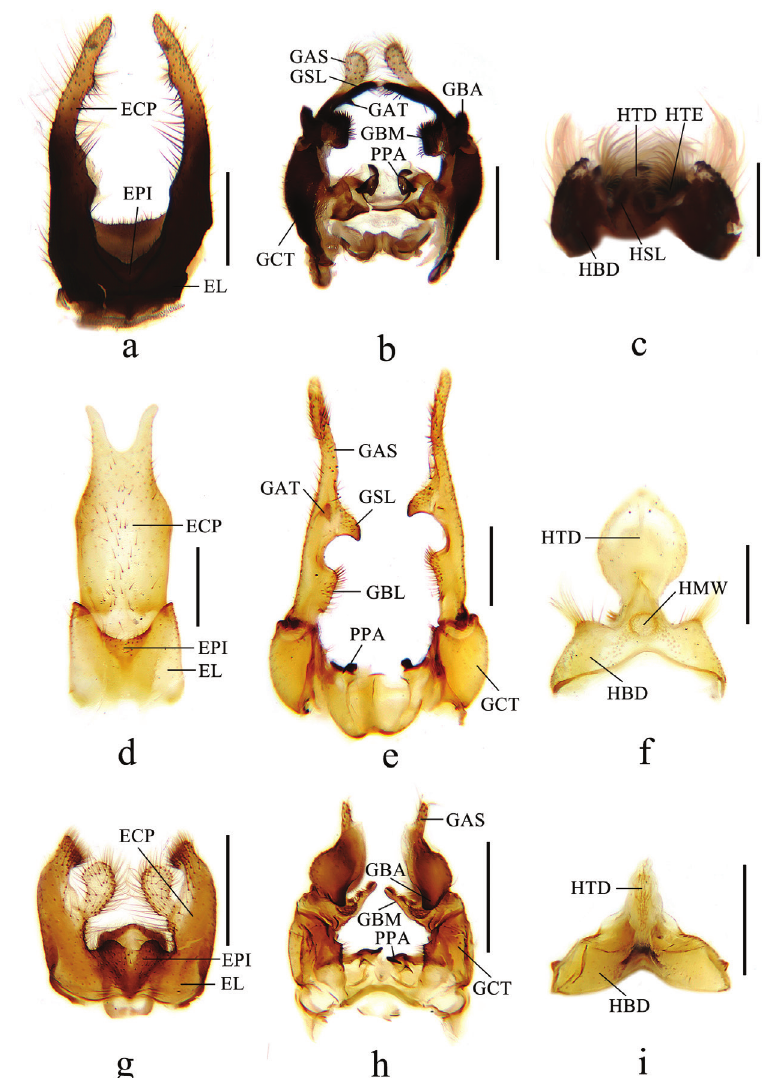
Figure 4. Details of male genitalia of new Ptychoptera species a epandrium of P. hekouensis , dorsal view b gonocoxite and gonostylus of P. hekouensis , dorsal view c hypandrium of P. hekouensis , ventral view d epandrium of P. longa , dorsal view e gonocoxite and gonostylus of P. longa , dorsal view f hypandrium of P. longa , ventral view g epandrium of P. xiaohuangshana , dorsal view h gonocoxite and gonostylus of P. xiaohuangshana , dorsal view i hypandrium of P. xiaohuangshana , ventral view. Scale bars: 0.4 mm. (ECP = epandrial clasper, EL = epandrial lobe, EPI = epiproct, GAS = apical stylus of gonostylus, GBA = ante- rior lobe of basal lobe of gonostylus, GBL = basal lobe of gonostylus, GBM = medial lobe of basal lobe of gonostylus, GCT = gonocoxite, GSL = secondary lobe of apical stylus of gonostylus, GAT = tertiary lobe of apical stylus of gonostylus, HBD = basal division of hypandrium, HMW = membranous window of terminal division of hypandrium, HSL = spathate lobe of hypandrium, HTD = terminal division of hyp- andrium, HTE = lateral extension of terminal division of hypandrium, PPA = apical process of